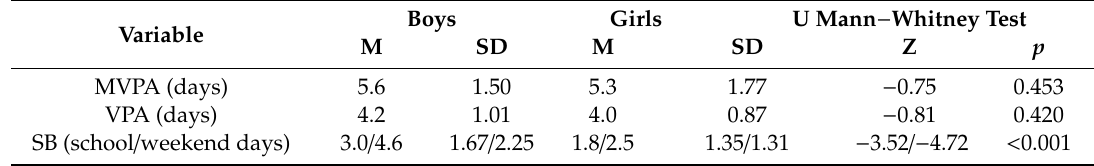
Table 5. Descriptive statistics for physical activity and sedentary behavior.